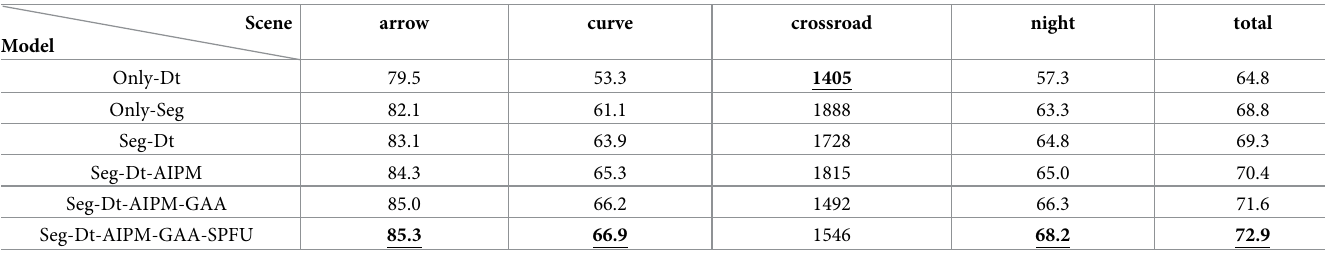
Table 5. Ablation experiments of GAAN with different modules. Scene arrow curve crossroad night total Model 79.5